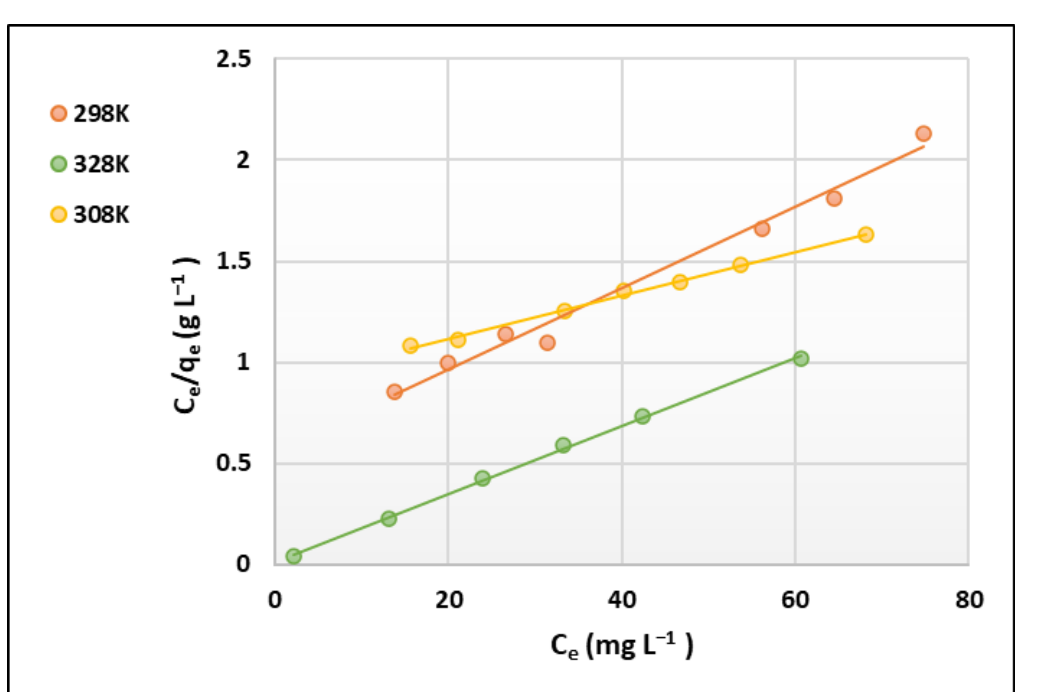
Figure 19. Langmuir isotherm plots for adsorption of CR dye onto 2Clph-BU-Cs adsorbent (m = 0.01 g, C 0 = 30–120 mg L −1 , V = 100 mL, pH = 4, and time = 48 h).